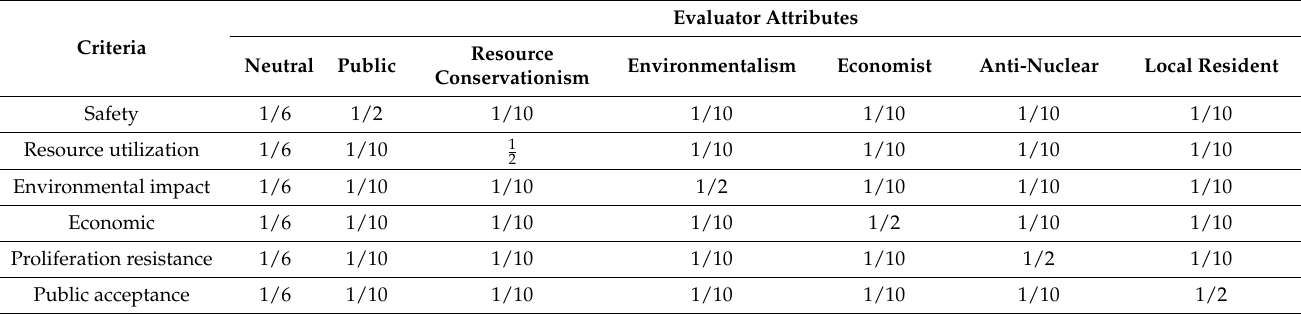
Table 13. Weights based on evaluator attributes.